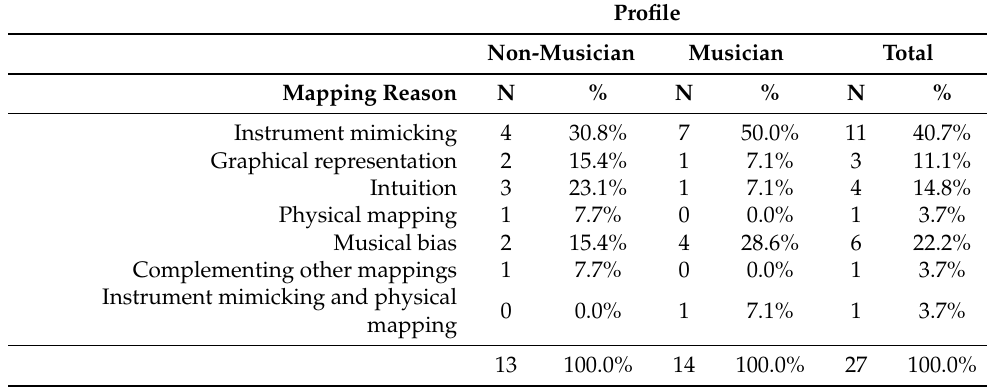
Table A17. Mapping rationale—stimulus